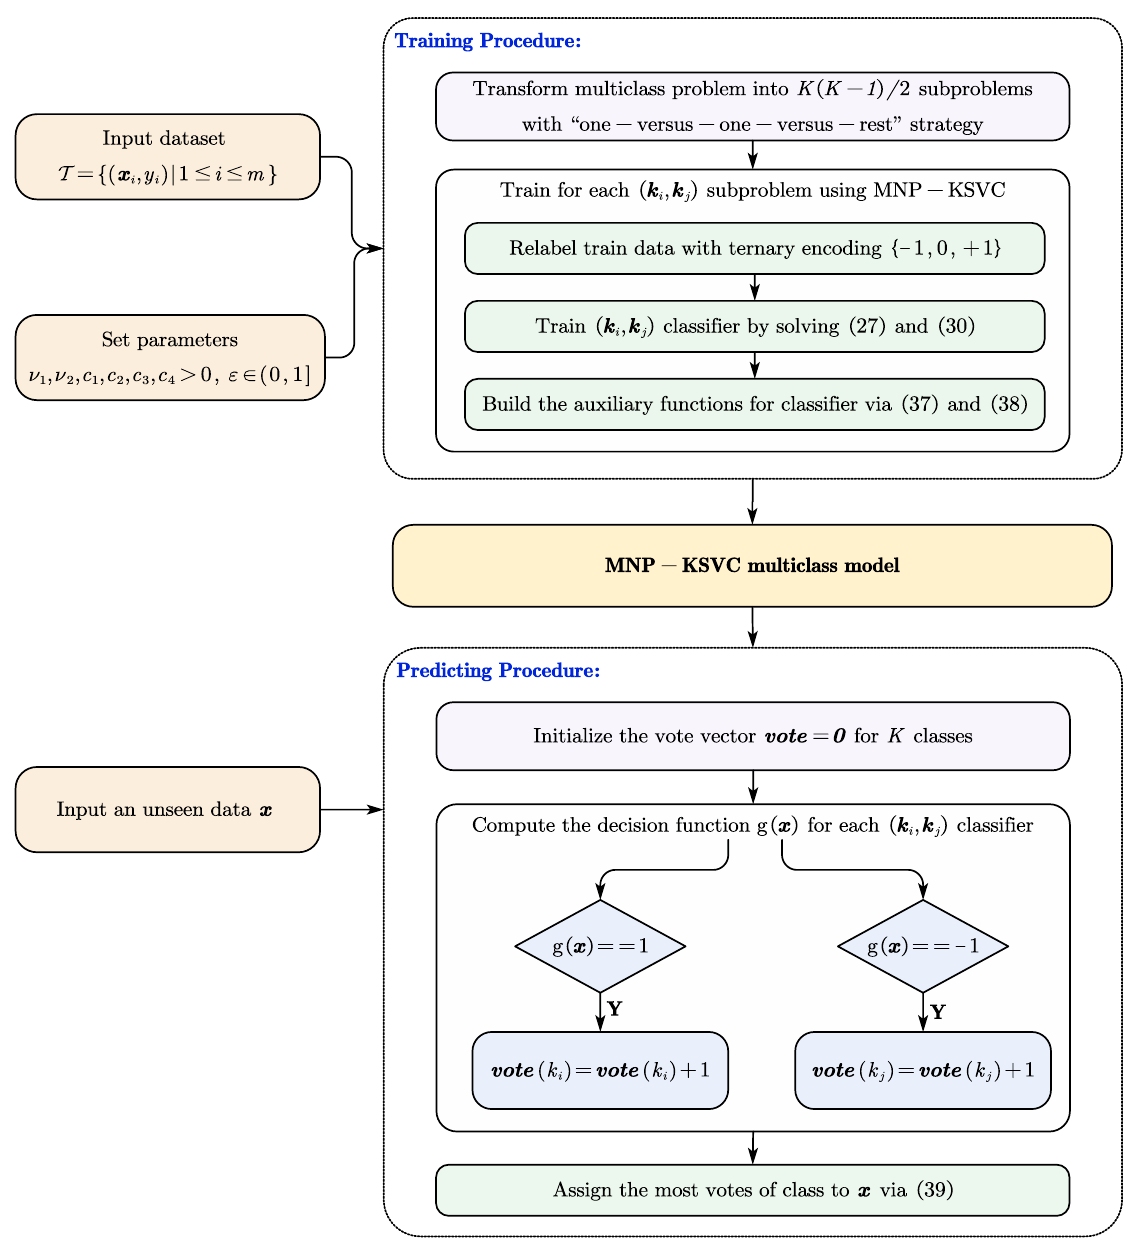
Figure 1. The flowchart for the training and predicting procedures of the proposed MNP-KSVC